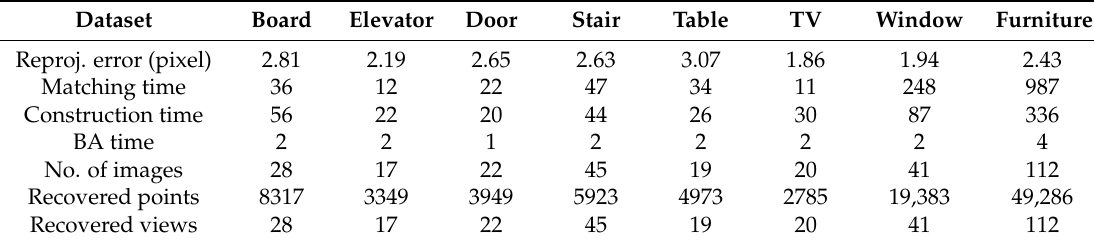
Table 2. The construction information for the separate point clouds (time units: s).